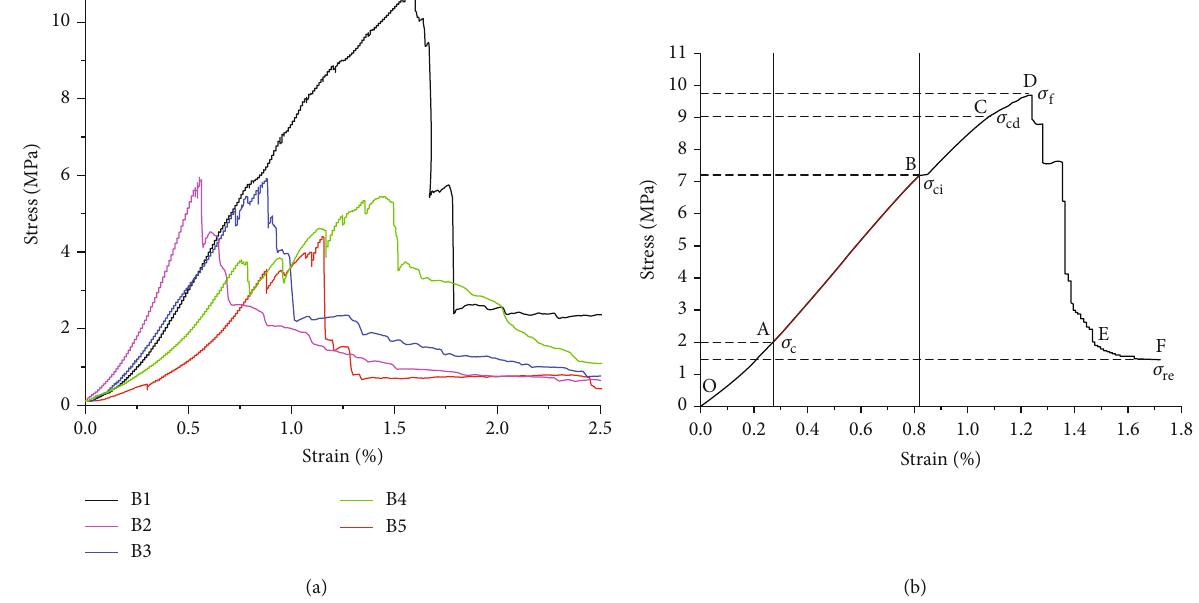
Figure 5: (a) Stress-strain curves of the coal samples. (b) The stress-strain curve through di ff erent